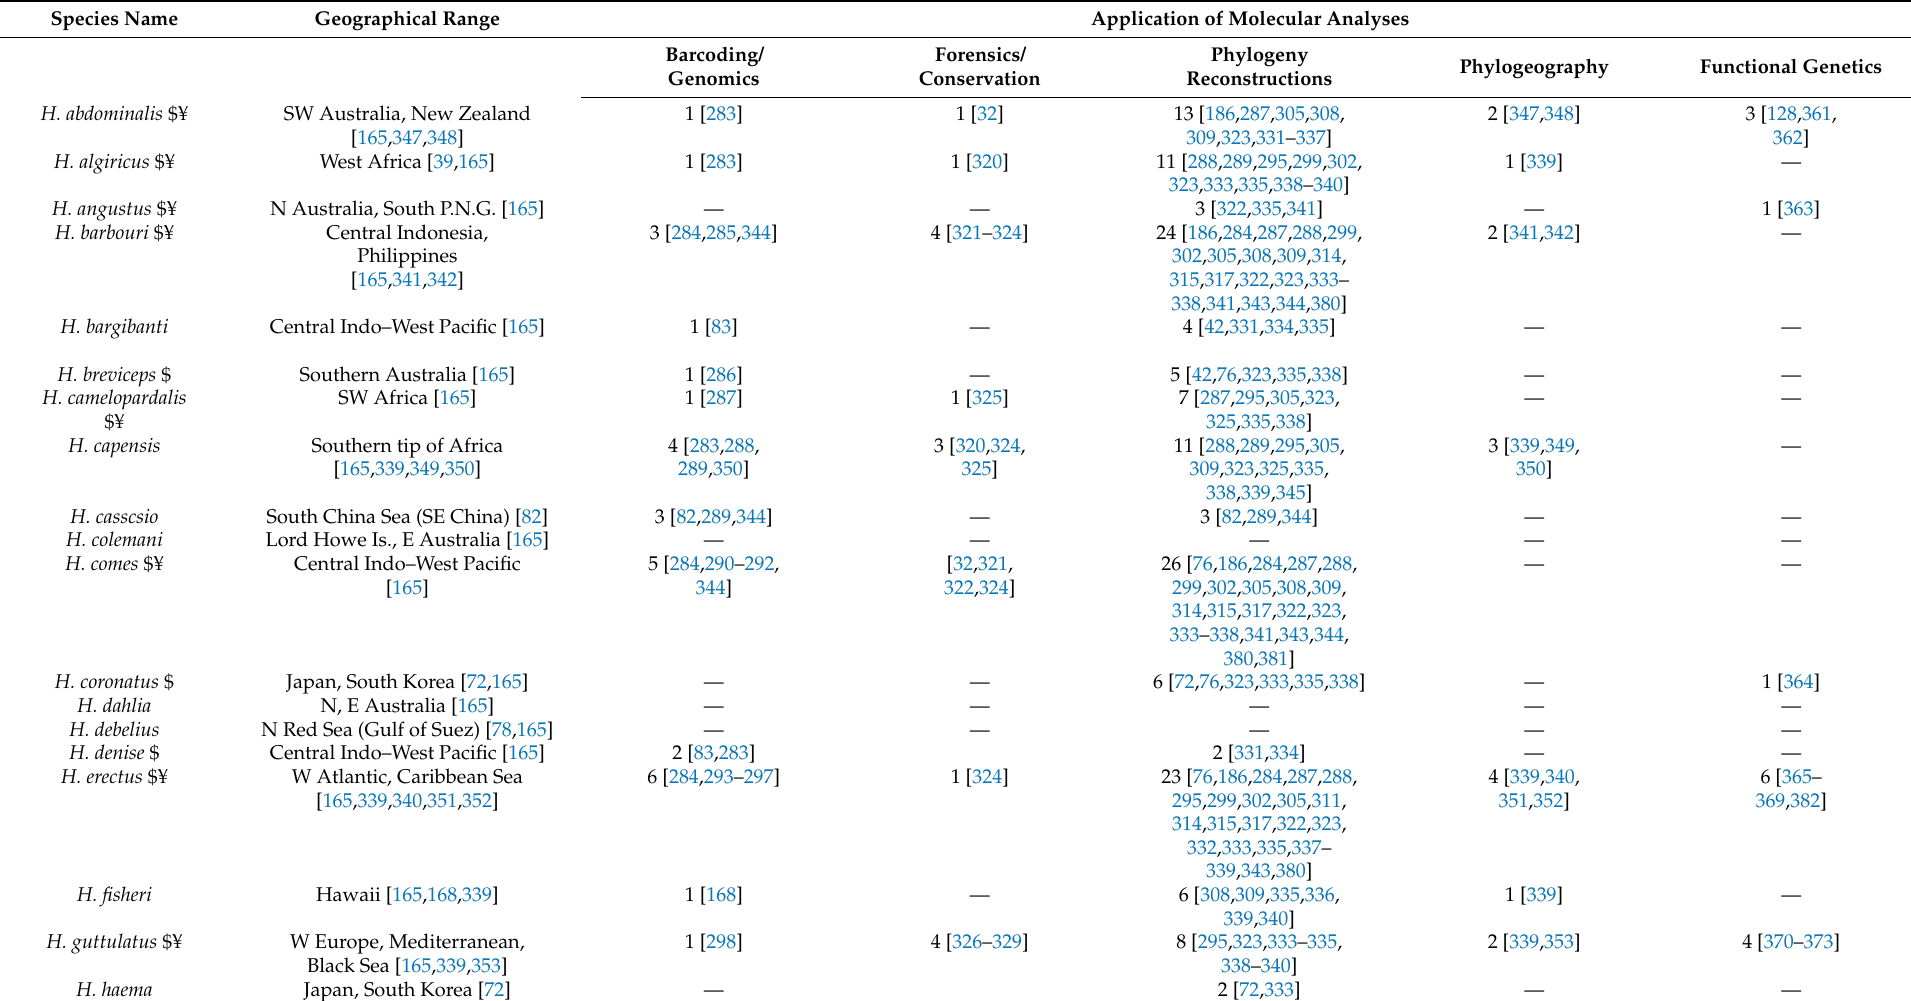
Table 5. Hippocampus species (Table 1), with geographical range, and numbers of molecular studies for five categories of application (with references; e.g., [283–382]). $ = in international aquarium trade, ¥ = in traditional medicine